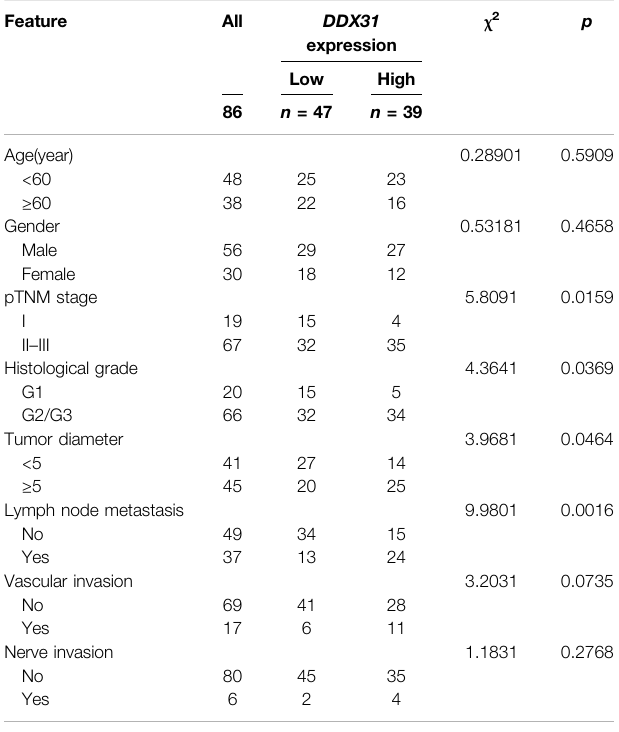
TABLE 1 | Relationships of DDX31 expression and clinicopathological characteristics in 86 patients with PC.